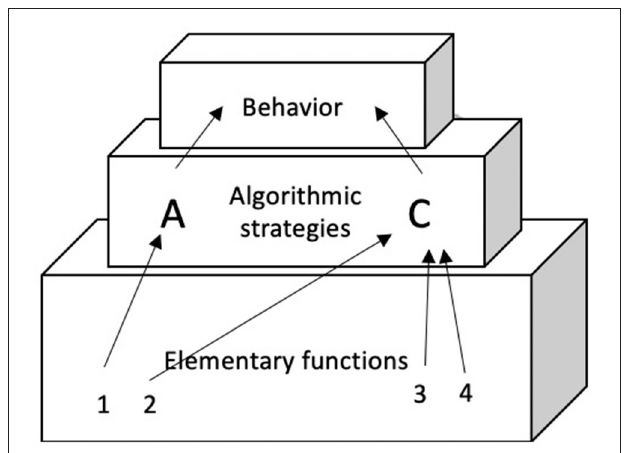
FIGURE 2 | The REFGEN model (re-drawn from Mogensen and Overgaard,